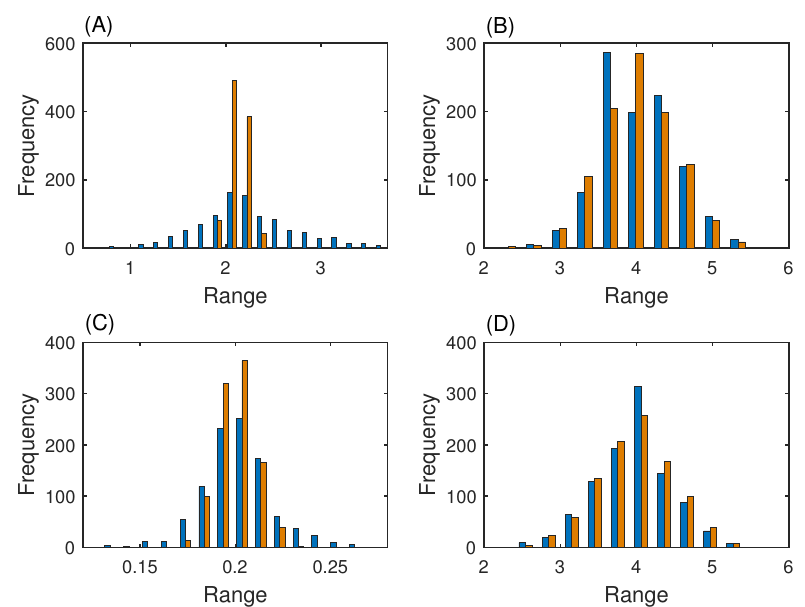
Figure 5. Simulated distributions of the parameters of Model (6). ( A ) Parameter s . ( B ) Parameter β 1 . ( C ) Parameter α 2 . ( D ) Parameter β 2 (orange bar: distributions of simulated parameters, blue bar: distributions of exact